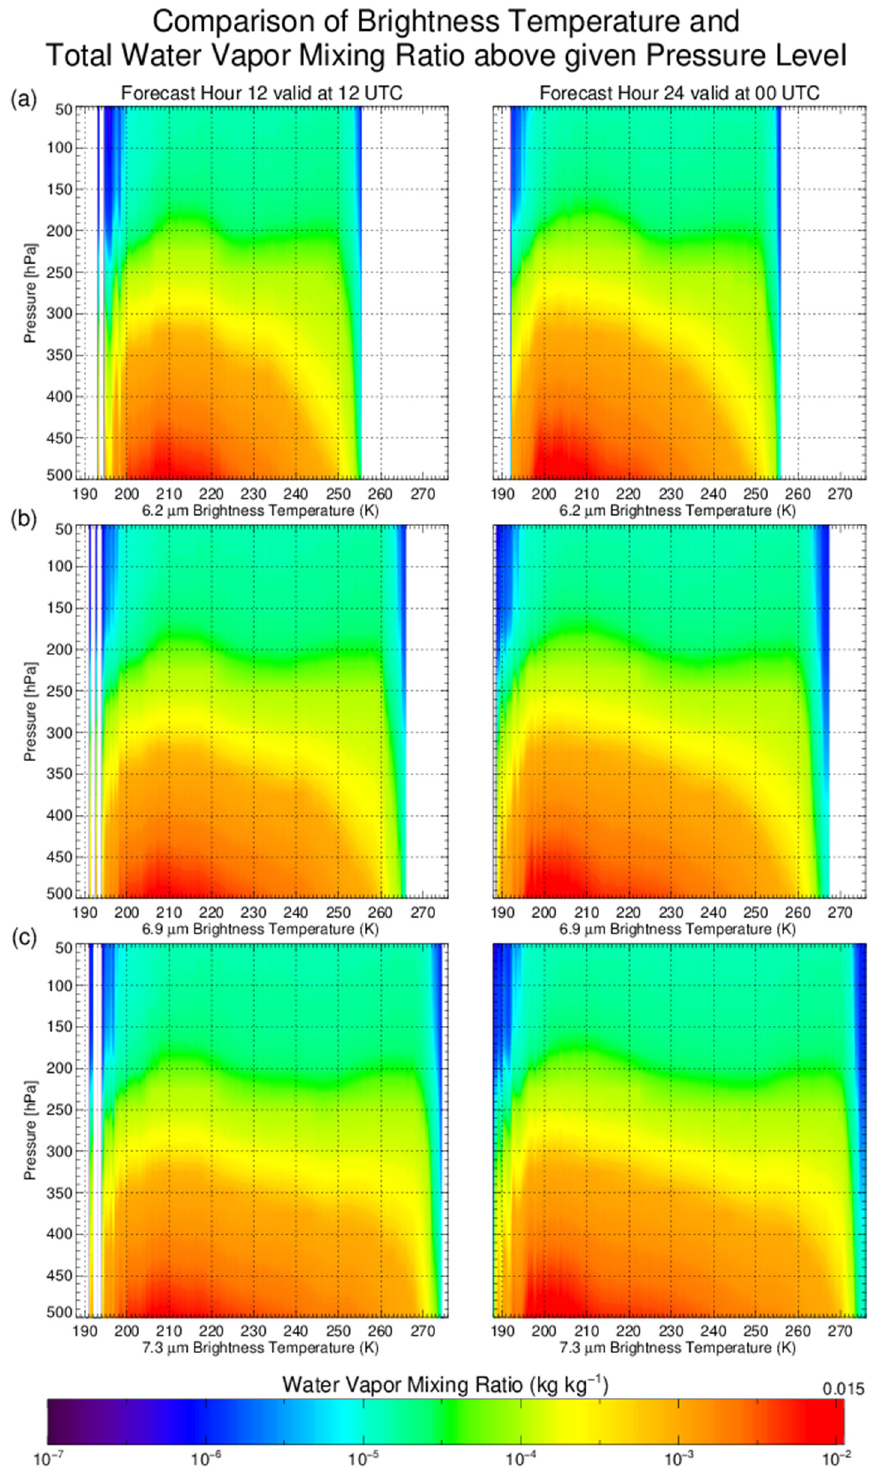
Figure 5. Comparison of the averaged total water vapor mixing ratio above a given pressure level for simulated ( a ) 6.2 µ m, ( b ) 6.9 µ m, and ( c ) 7.3 µ m brightness temperatures for all EMC FV3-LAM grid points, averaged over all 12 h ( left ) and 24 h ( right ) forecasts.